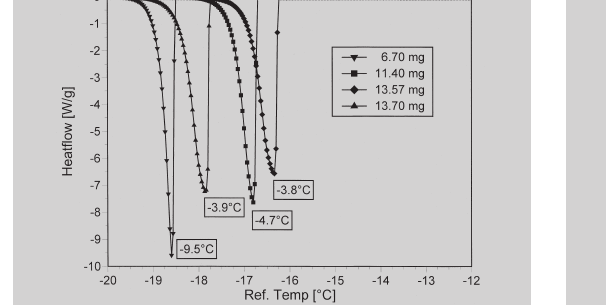
Figure 1 (left): DSC cooling curves for o/w emulsion A (Typical Graphics: heatflow versus reference temperature). Figure 2: DSC cooling curves for o/w emulsion A (Graphics: heatflow versus sample